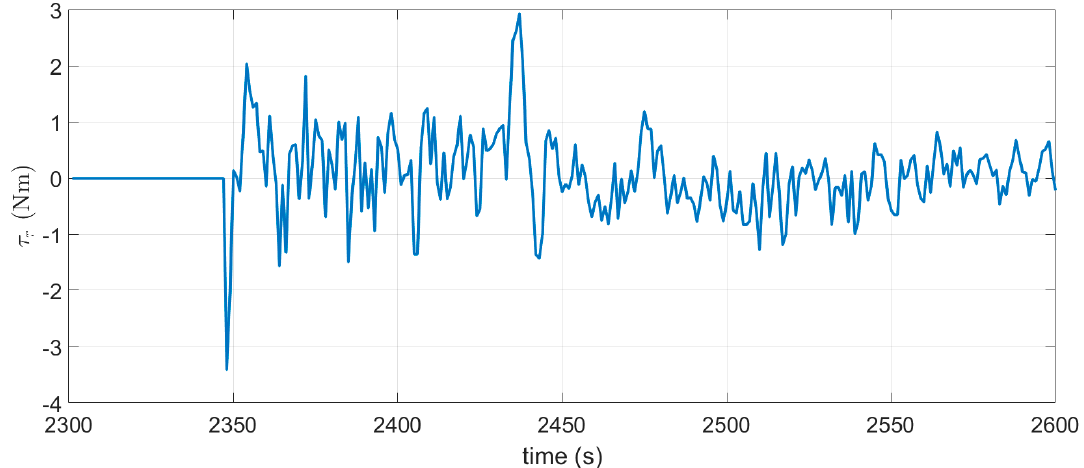
Figure 19. Experimental performance of heading and yaw rate in the sea in front of the Korea Maritime and Ocean University (KMOU, Busan, South Korea): ( a ) Heading control performance ( b ) virtual control performance.